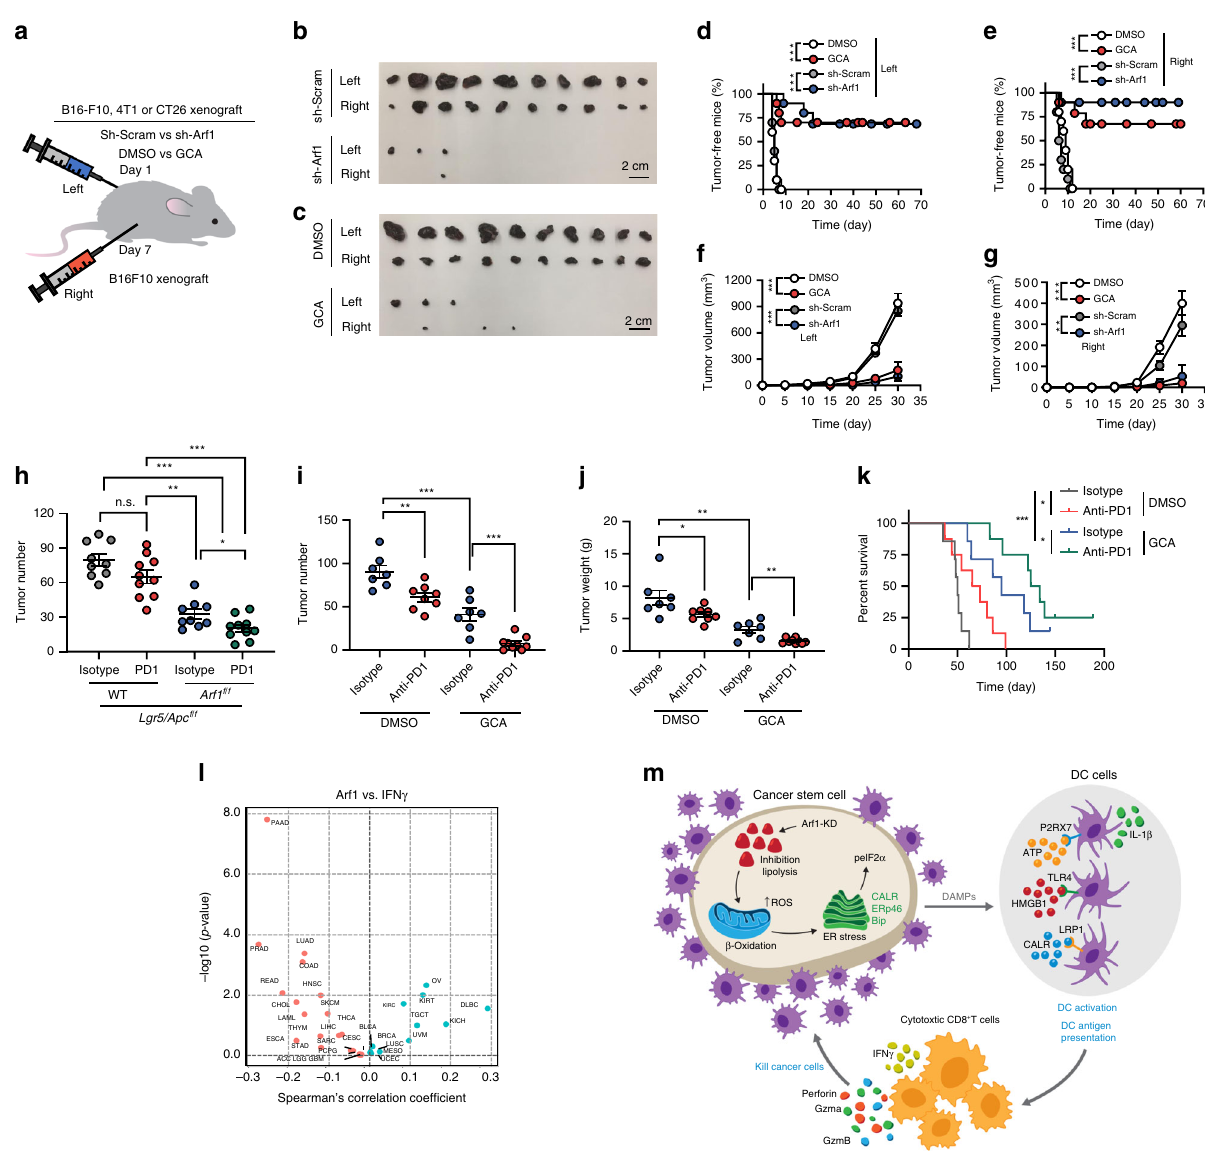
Fig. 7 Vaccination with Arf1-ablated cells protects animals from developing tumors. a Experimental setup. B16-F10 cells that were transfected with sh- Arf1 or sh-Scram or treated with the Arf1 inhibitor GCA or DMSO were injected into the left side of C57BL/6J mice, and the mice were then re-challenged 1 week later with untreated B16-F10 cells on the right side. b , c Tumor sizes from B16-F10 cells treated with the indicated reagents and transplanted into C57BL/6J mice. Scale bars: 2 cm. d , e Tumor-free curves of B16-F10 cells treated with the indicated reagents and transplanted into C57BL/6J mice. f , g Tumor-volume curves of B16-F10 cells treated with the indicated reagents and transplanted into C57BL/6J mice. h Intestinal tumor number of mice with the indicated genotypes after treatment with isotype or an anti-PD1 antibody. i Tumor numbers of MYC-ON mice treated with the indicated reagents. j Tumor weights of MYC-ON mice treated with the indicated reagents. k Survival curves of MYC-ON mice treated with the indicated reagents. l Correlation analysis for the Arf1 expression level versus IFN γ signature from a human cancer database. m Proposed model depicting how Arf1 knockdown promotes metabolic stress, the induction of DAMPs, and immune cell in fi ltration and activation to attack tumors ( b – g : n = 10; h : n = 10; i : n = 8; j : isotype group, n = 7, anti-PD1 group, n = 8; k : n = 8 mice each group; * p < 0.05, ** p < 0.01, *** p < 0.001 by Student ’ s t -test; polled two independent experiments). Data are shown as the mean ±